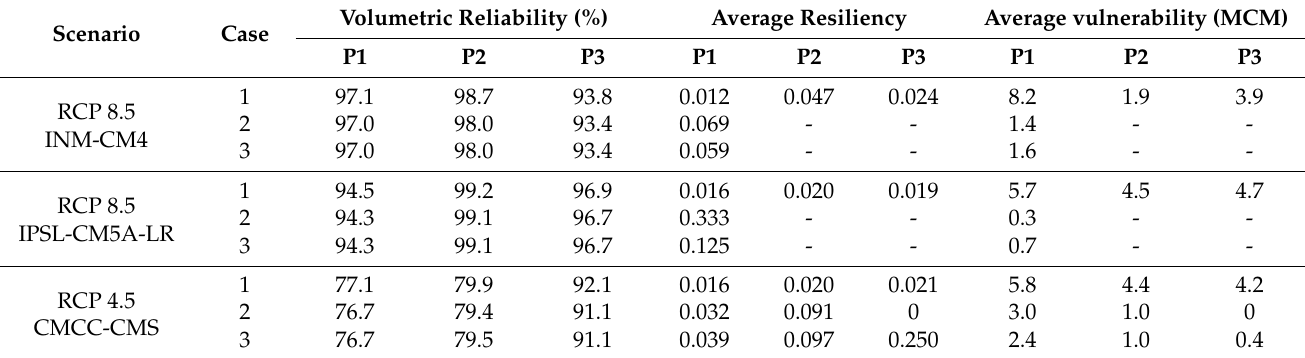
Table 8. Results of the three model performance evaluation indices for Case 1, 2, and 3 in